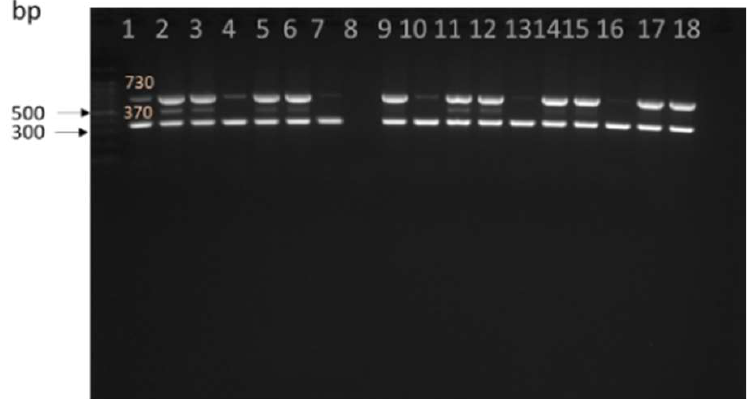
Figure 3. Amplification of prs for Listeria and hly of genes in L. monocytogenes . Lane 1 and 9 positive control: Listeria monocytogenes ATCC 19115, lane 8- Blank/control, Lane 2–7 and 10–18 positive samples.